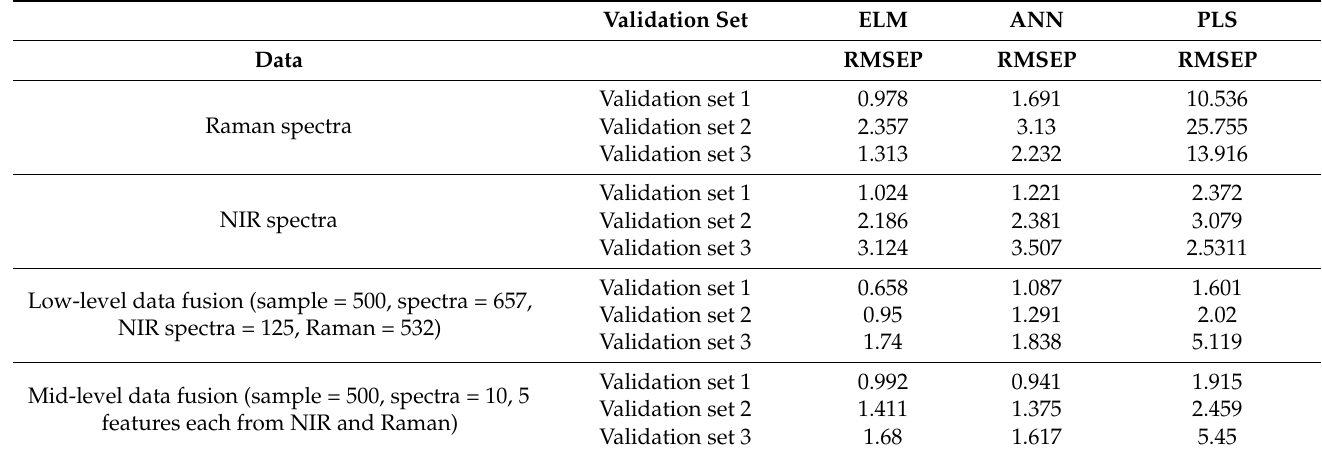
Table 2. Summary of result for all validation sets.